Question: Which visualization type does this figure use?
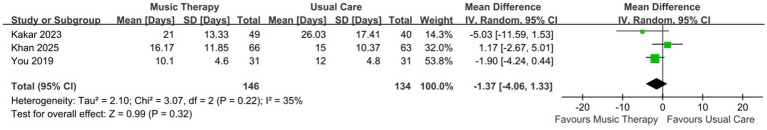
Answer: forest